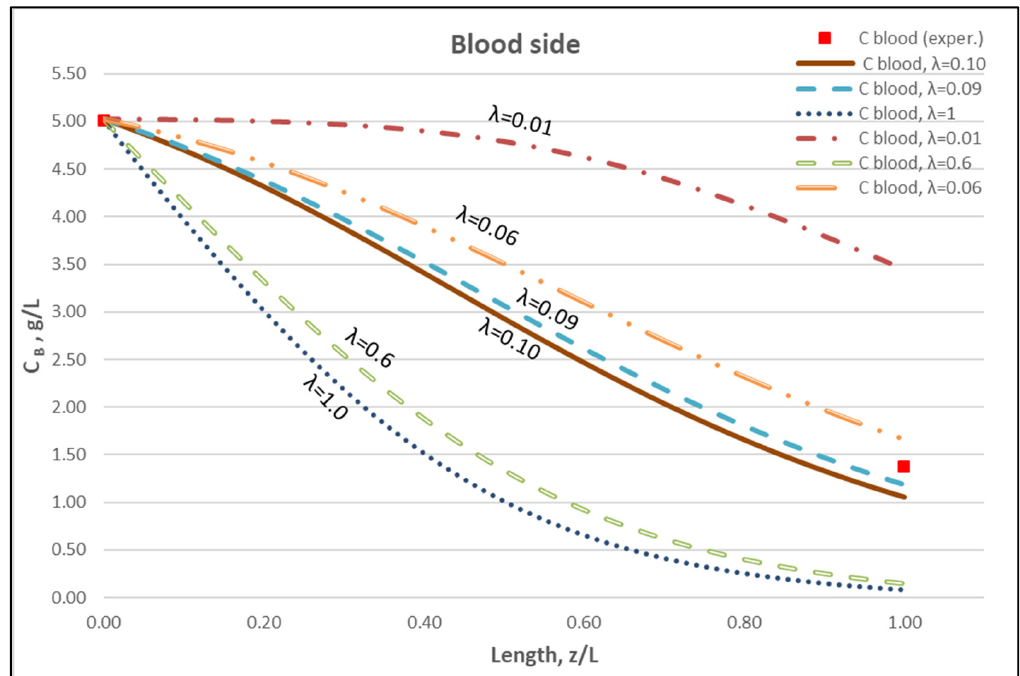
Figure 12. Blood-side urea concentration profile. Influence of the urea effective diffusion coefficient in the membrane (D e ) on urea mass transfer, under simultaneous trans-membrane liquid convection and solute diffusion. Case (I): Q Blood = 200 mL/min − Q Dialysate = 300 mL/min.